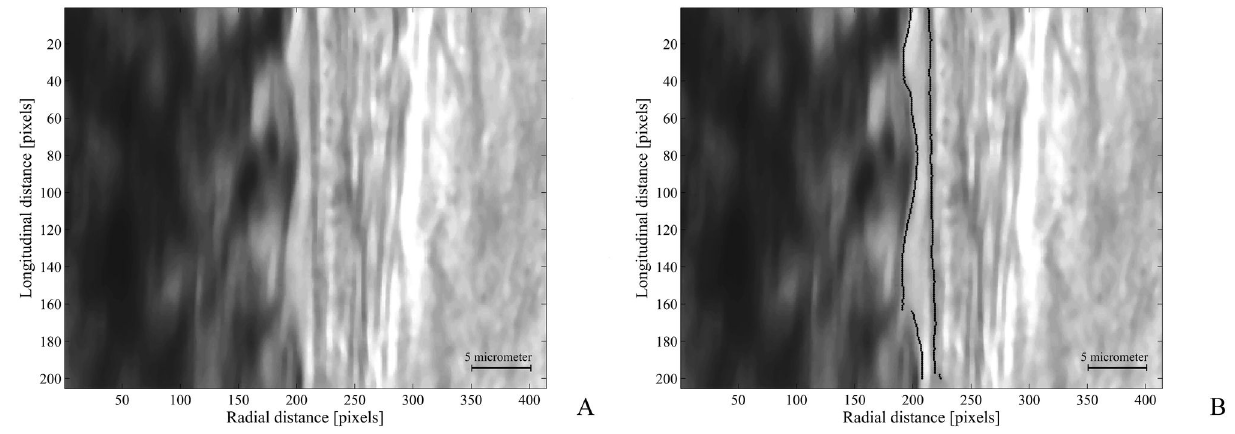
Figure 4. Data analysis. An example of a section of an artery before data analysis (Figure 4A) and after tracing the RBC column and vessel wall over a length of 200 pixels (Figure 4B). The difference between vessel wall and RBC column is defined as the CFL. doi: